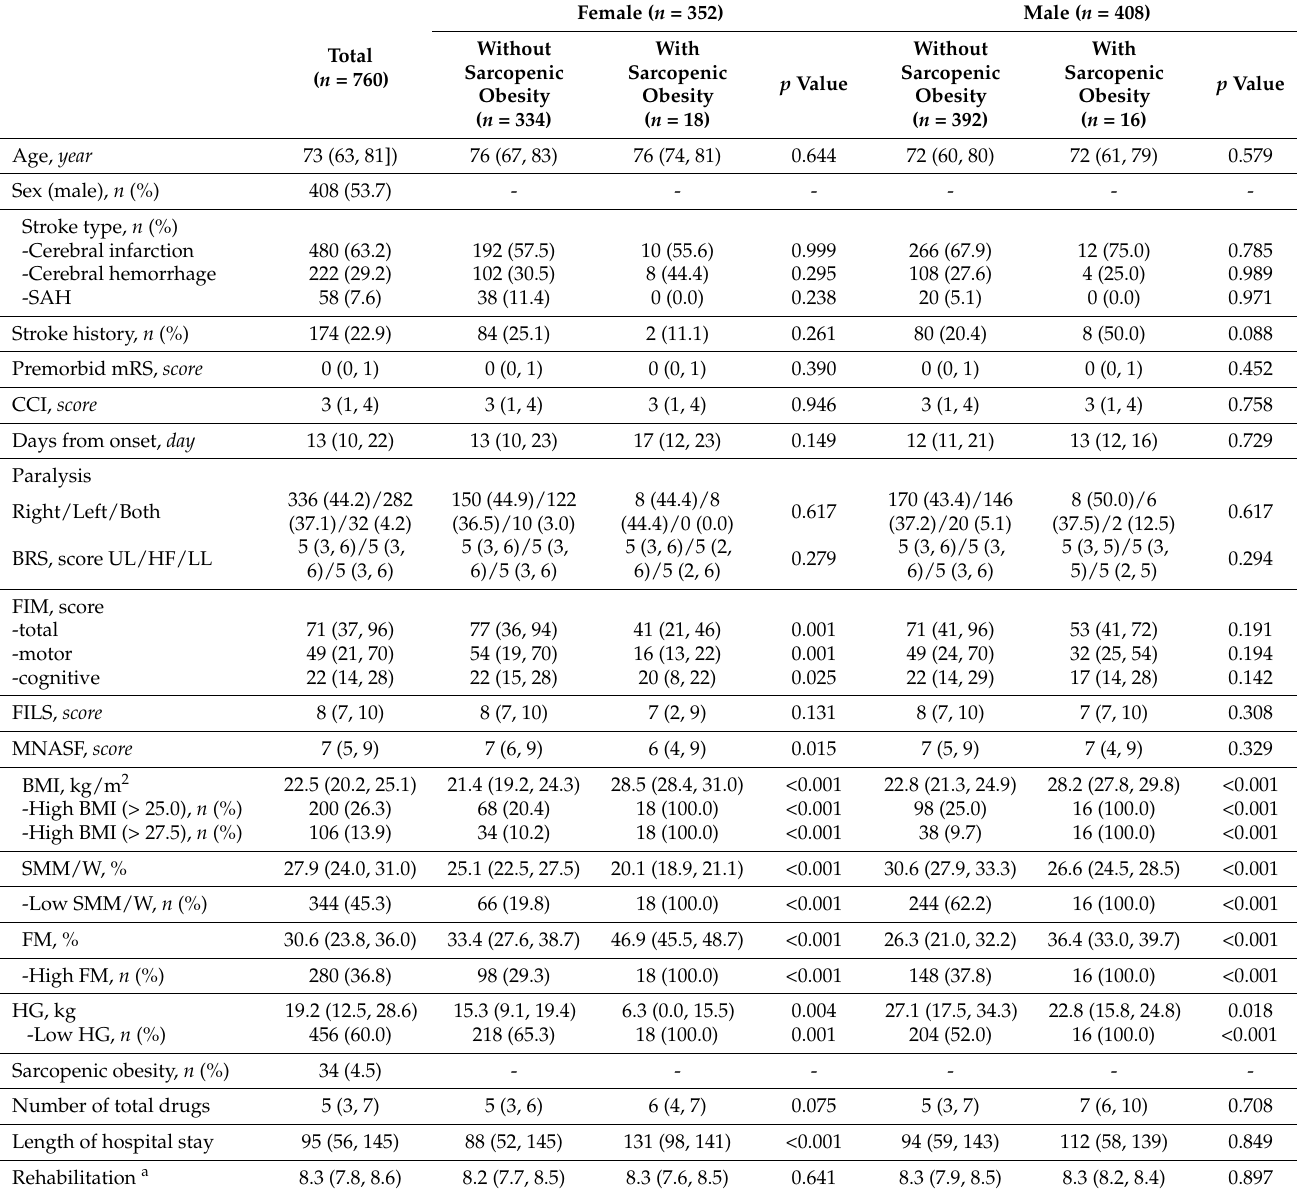
Table 2. Baseline patient characteristics and univariate analyses for variables between patients with and without sarcopenic obesity defined by ESPEN and EASO criteria 2022 in females and males using BMI > 27.5 kg/m 2 as the obesity